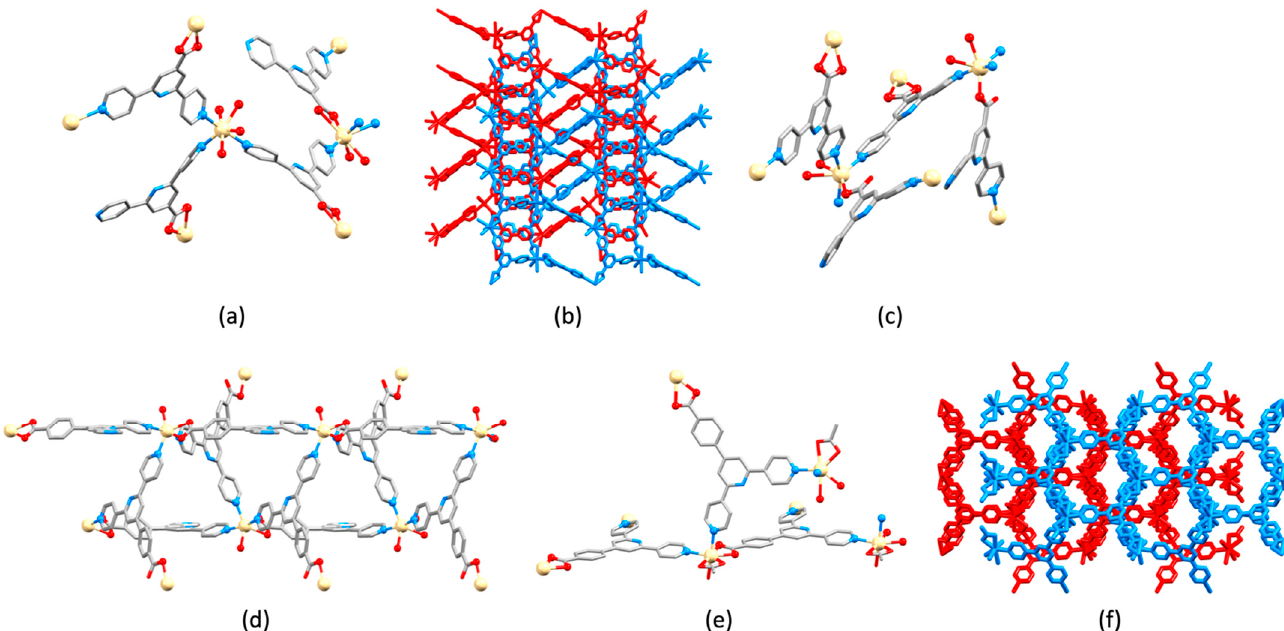
Figure 32. (a) The Cd(II) coordination environments and ligand coordination modes in [Cd 2 ( 31 ) 4 ] n (CSD refcode KEPLID), and (b) the 2 ‐ fold interpenetrated 3D ‐ network in [Cd 2 ( 31 ) 4 ] n . (c) (a) The Cd(II) coordination environments and ligand co ‐ ordination modes in [Cd 2 ( 31 ) 4 ] n . 2 n H 2 O (CSD refcode XIDCEU). (d) Part of the 2D ‐ net in [Cd( 17 ) 2 ] n . 2 n DMF (refcode HEKTEY). (e) In [Cd( 17 )(OAc)(OH 2 )] n . n DMA . n H 2 O (CSD refcode HEKTAU), both the Cd(II) center and 17 – ligand are 3 ‐ connecting nodes. (f) The 2 ‐ fold interpenetrating ths nets in [Cd( 17 )(OAc)(OH 2 )] n . n DMA . n H 2 O.